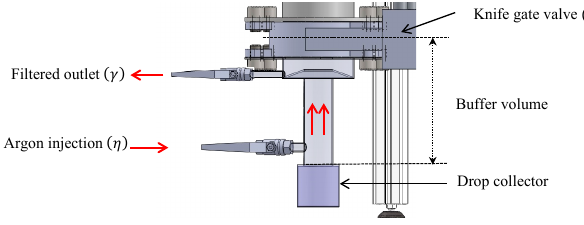
Figure 9. Buffer volume flushing